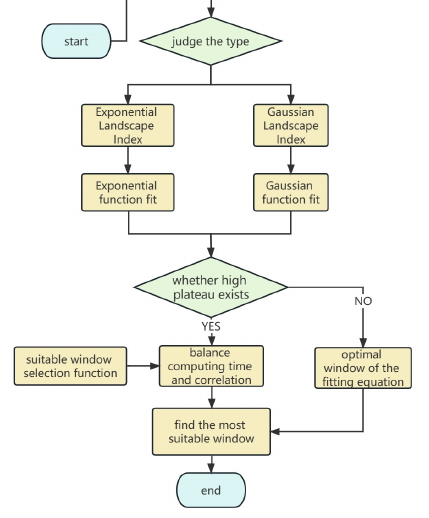
Figure 5. The fl ow chart of method of selecting suitable window. Figure 5. The flow chart of method of selecting suitable